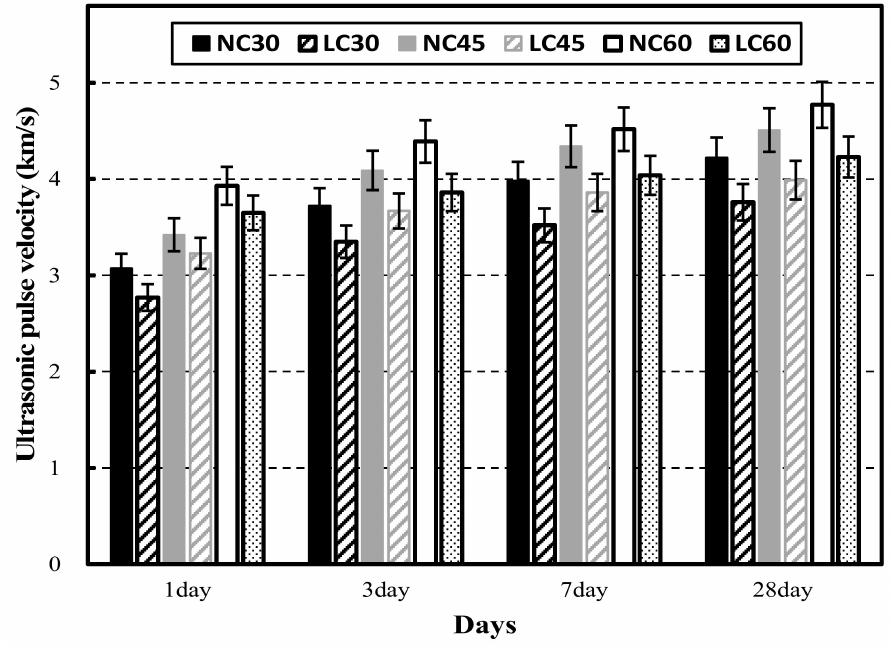
Figure 3. Ultrasonic pulse velocity of normal aggregate concrete and lightweight aggregate concrete at different